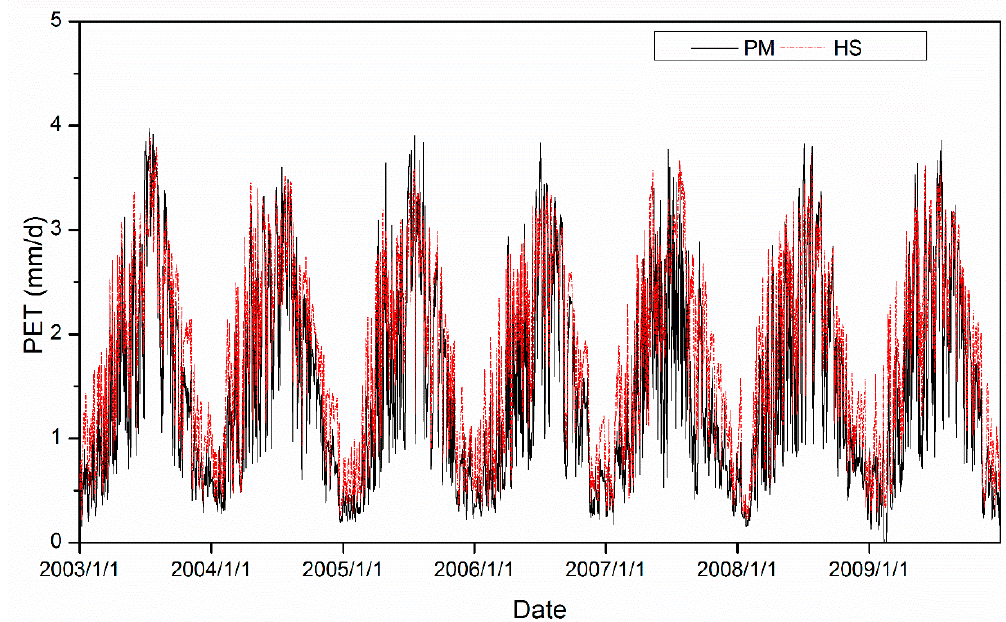
Figure 3. Regional mean daily PET over basin from 1 January 2003 to 31 December 2009.